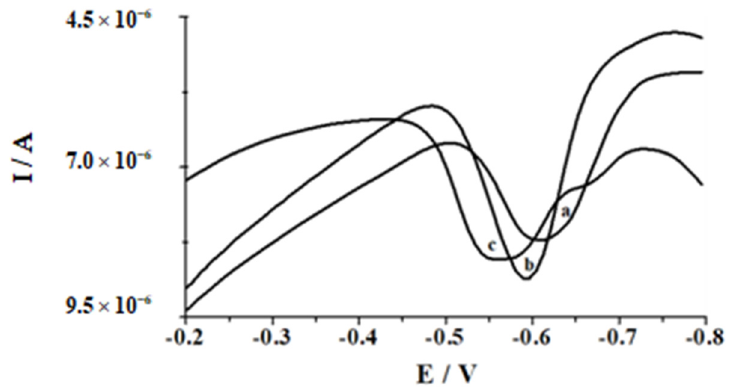
Figure 2. The voltammograms illustrating the influence of Bi(III) concentration on the peak current and potential of 3 × 10 − 7 mol L − 1 Se(IV). Concentration of Bi(III): (a) 4.8 × 10 − 6 mol L − 1 ; (b) 1.9 × 10 − 5 mol L − 1 ; (c) 1.9 × 10 − 4 mol L − 1 . Steady concentration: 3 × 10 − 7 mol L − 1 Se(IV), 0.1 mol L − 1 acetic acid.